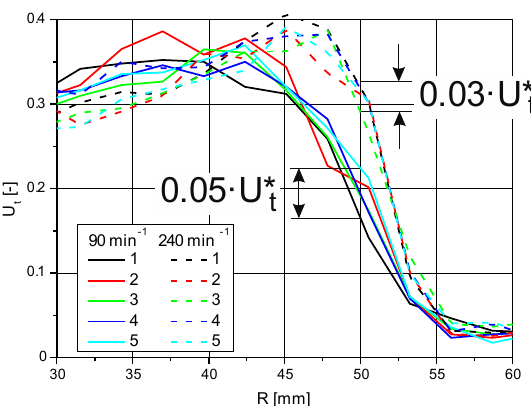
Figure 8. Profiles for five consecutive measurements (PBT45, h w = 140 mm).